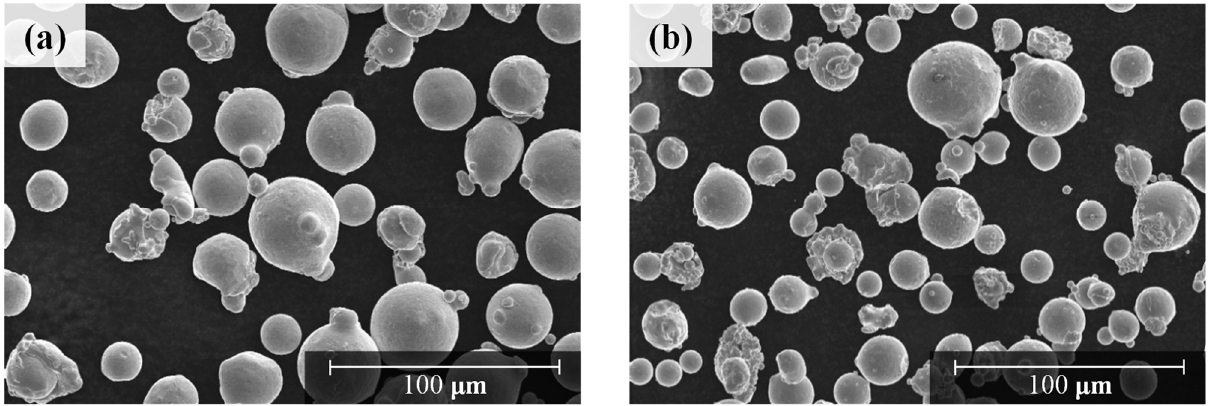
Figure 2. Shape image of two types of Hastelloy X powder used in the LPBF process: ( a ) Powder I, ( b ) Powder II.